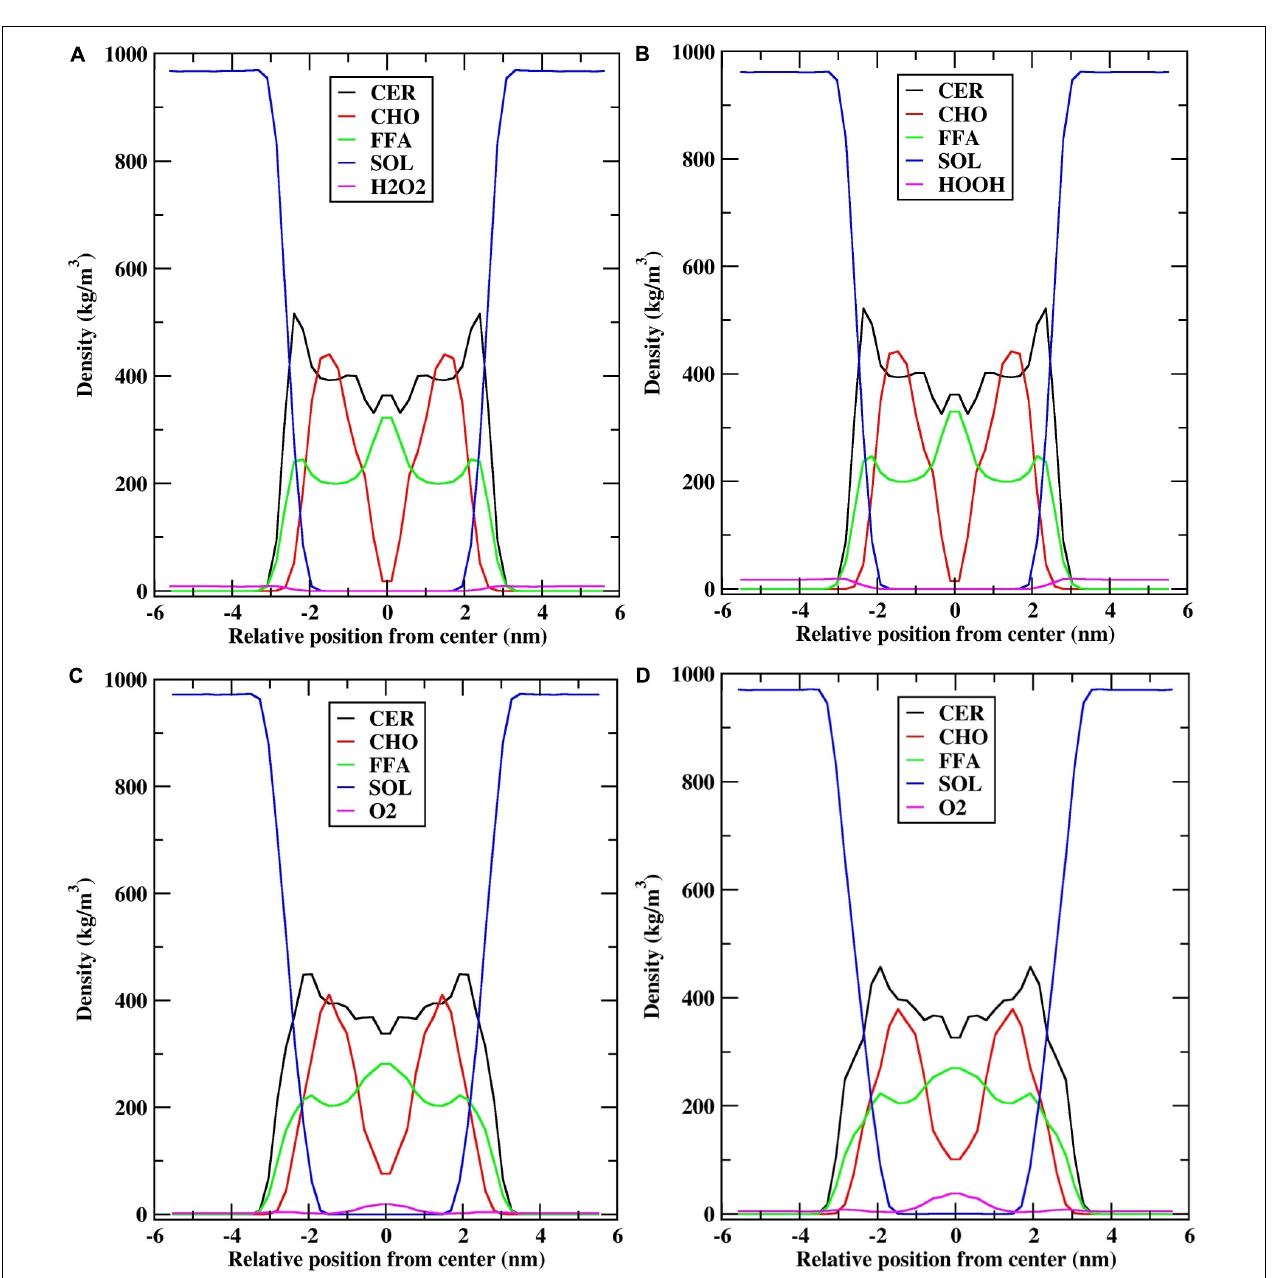
FIGURE 4 | Density profile of individual lipid components (CER-CHO-FFA) along the bilayer normal ( z ). (A) H 2 O 2 -25; (B) H 2 O 2 -50; (C) O 2 -25; and (D) O 2